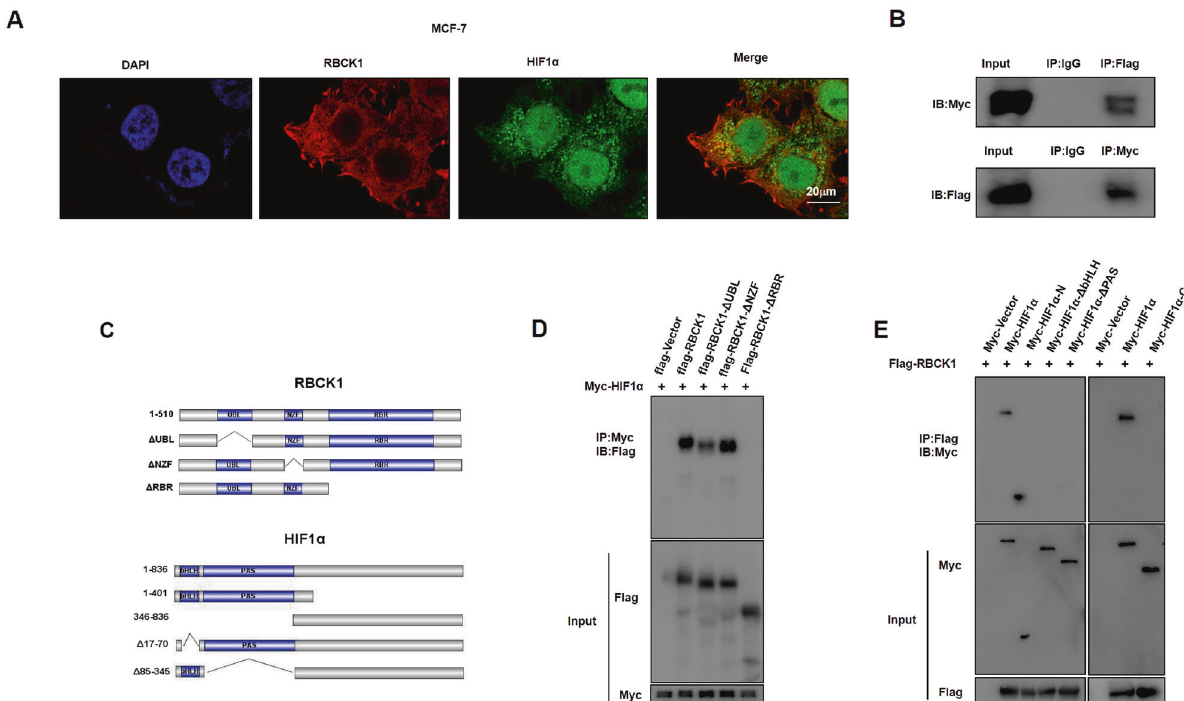
Fig. 5 RBCK1 associates with HIF1 α N-terminal through its RBR domain. A Intracellular localization analysis of RBCK1 and HIF1 α by immuno fl uorescence assay. Immuno fl uorescence experiments are not started until MCF-7 is in good condition. This fi gure illustrates the intracellular localization of MCF-7, where HIF1 α is green, and RBCK1 is red. The nucleus is stained blue by DAPI. B Co-IP assay revealed an association between RBCK1 and HIF1 α in HEK293T cells. Flag-RBCK1 and Myc-HIF1 α were co-transfected in HEK293T, and HEK293T cells